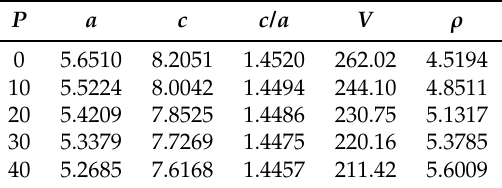
Table 2. Optimized lattice parameters a , c (in Å), c / a , cell volume (in Å 3 ) and mass density ρ (in g/cm 3 ) of Ti 4 Nb 3 Al 9 under different